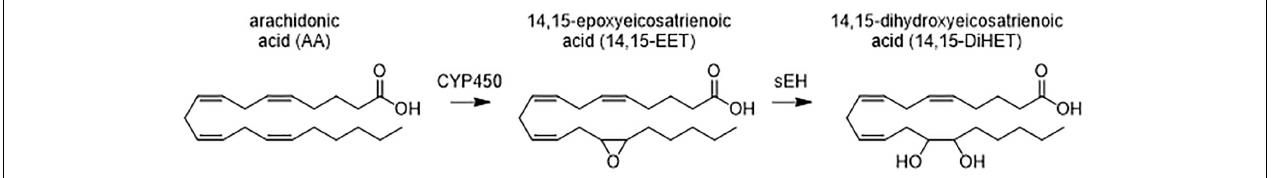
FIGURE 1 | Metabolism of arachidonic acid (AA) by cytochrome P450 (CYP450) generates anti-inflammatory fatty acid epoxides (EETs) that are degraded by the soluble epoxide hydrolase (sEH) to the corresponding 1,2 diols (DiHETs). DiHETs are more polar and diffuse out of the cells and are readily conjugated and excreted. The omega-6 fatty acid, AA, and representative metabolites on the 14, 15 carbon position are shown. Similar epoxides and vicinal diols are formed on the double bonds, and other omega-3 and 6 PUFAs are metabolized in a similar fashion.